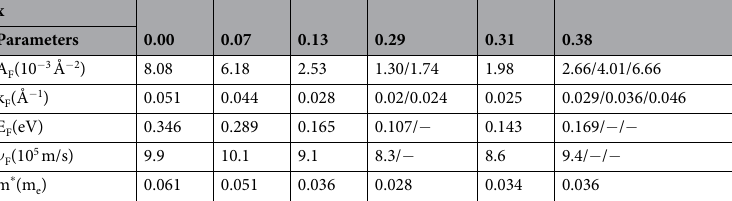
The band structure calculation for Cd 3 (As 1 − x P x ) 2 revealed a topological phase transition from a Dirac semi- metal to a trivial semiconductor induced by the change of the SOC strength 31 . When x increases, the two Dirac points along the k z axis gradually move closer and then merge at the Γ point under the protection of the crystal symmetry. A direct band gap is opened beyond the critical point. The process of the band inversion transition in (Cd 1 − x Zn x ) 3 As 2 should be similar as that in Cd 3 (As 1 − x P x ) 2 . Despite of large chemical replacement in the crystals,